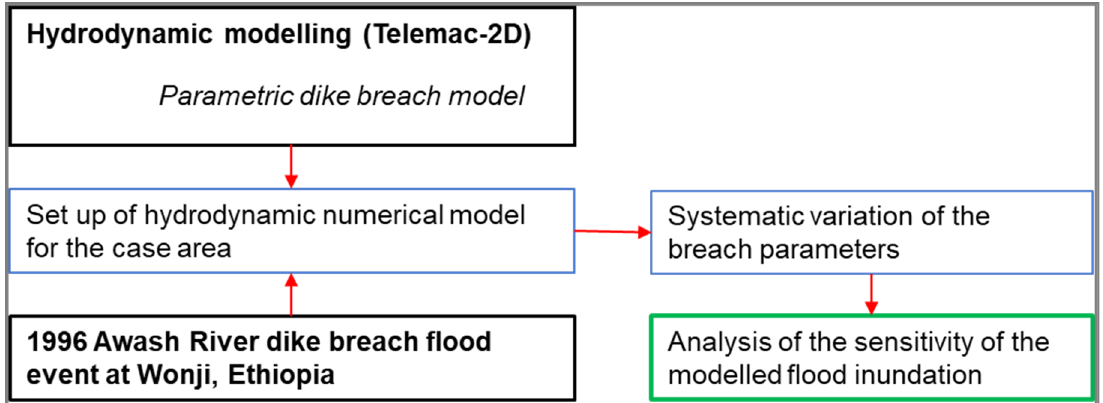
Figure 1. Schematic diagram of the proposed approach for the sensitivity analysis.